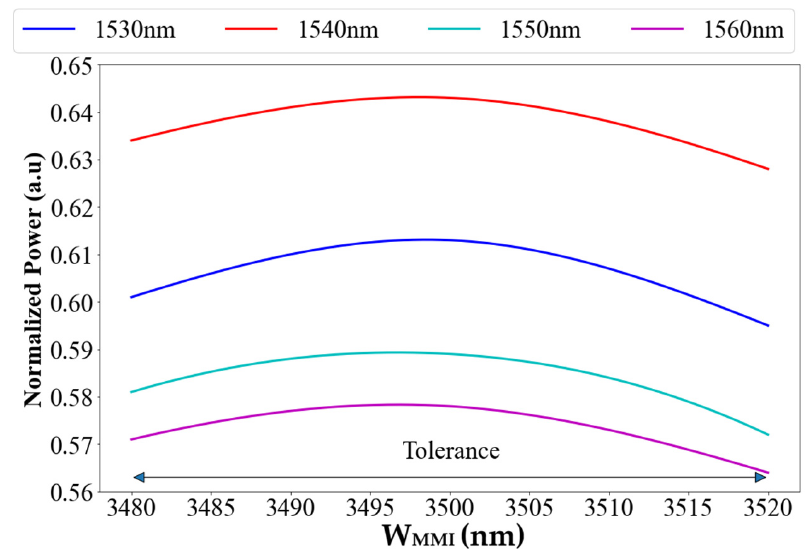
Figure 4. Normalized power as a function of MMI width for each wavelength.